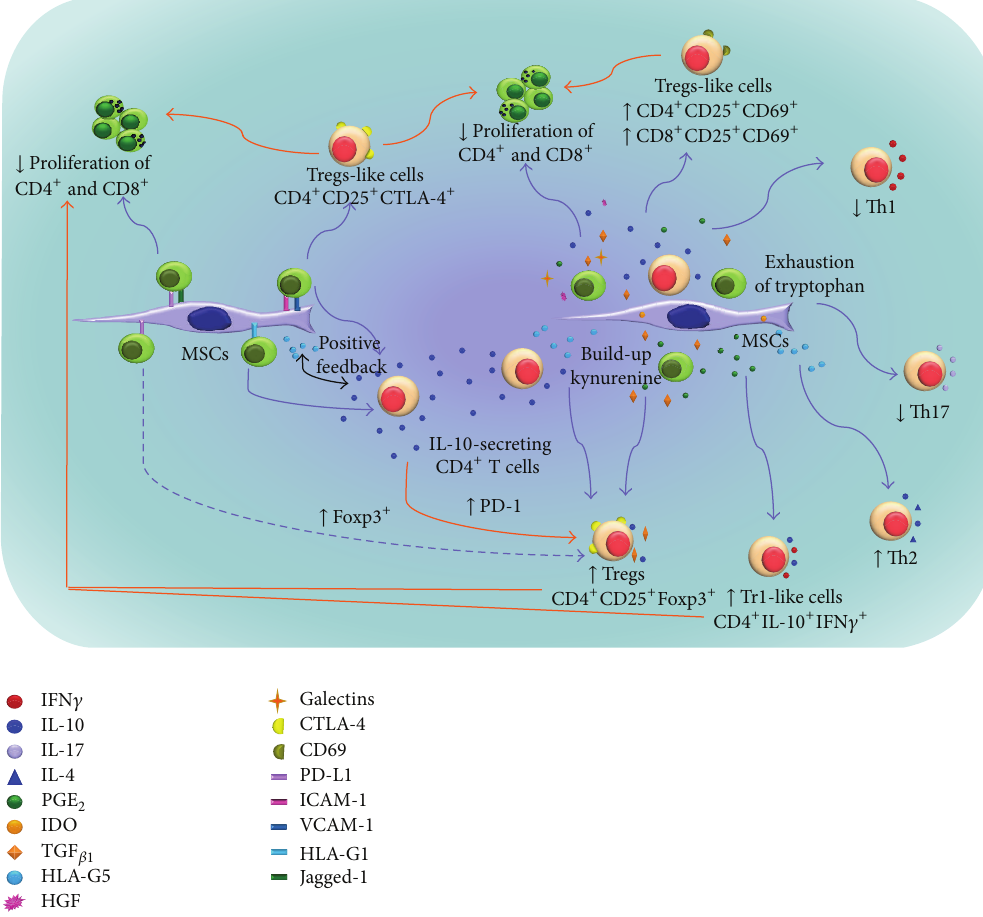
Figure 1: Immunoregulatory effect of MSCs on T lymphocytes. MSCs can induce the sustained expression of CTLA-4 and CD69 activation molecules on T cells, which have been related with generation of cells with immunoregulatory properties. Cell-to-cell contact seems to be required for the increase of CTLA-4 expression. Dependent and independent mechanisms of cellular contact are involved in the decrease of proliferation of CD4 + and CD8 + T cells and in generation of Foxp3 + Tregs by MSCs. Cytokines such as IL-10 can stimulate the expression and secretion of HLA-G5 by MSCs and in turn it stimulates the secretion of IL-10 in a positive feedback loop. The initial contact between MSCs and T lymphocytes seems to be required for initiation of the feedback loop. PGE 2 secreted by MSCs is involved in generation of Tr1 cells. HLA-G5 supports differentiation of Th2 cells and IDO decrease differentiation of